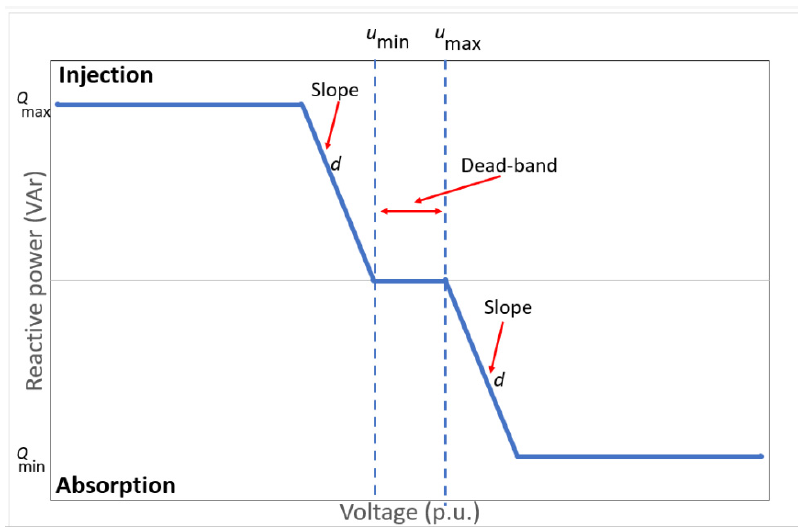
Figure 4. Voltage/Var function requirement for inverters [24] .